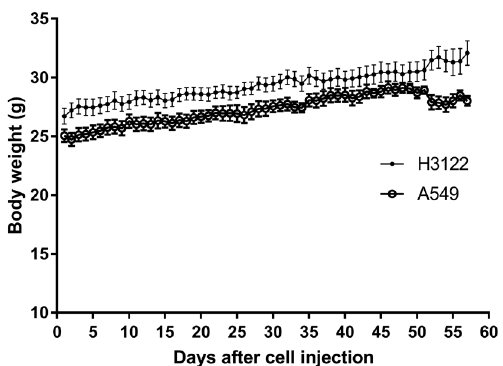
Figure 1. Body weight of SCID mice injected with A549 or H3122 human lung adenocarcinoma cells via the tail vein over 8 weeks. Data points are means and error bars are SEM. Up to week three there were fur mice for each cell type. Four mice were then sacrificed, and another four mice at week